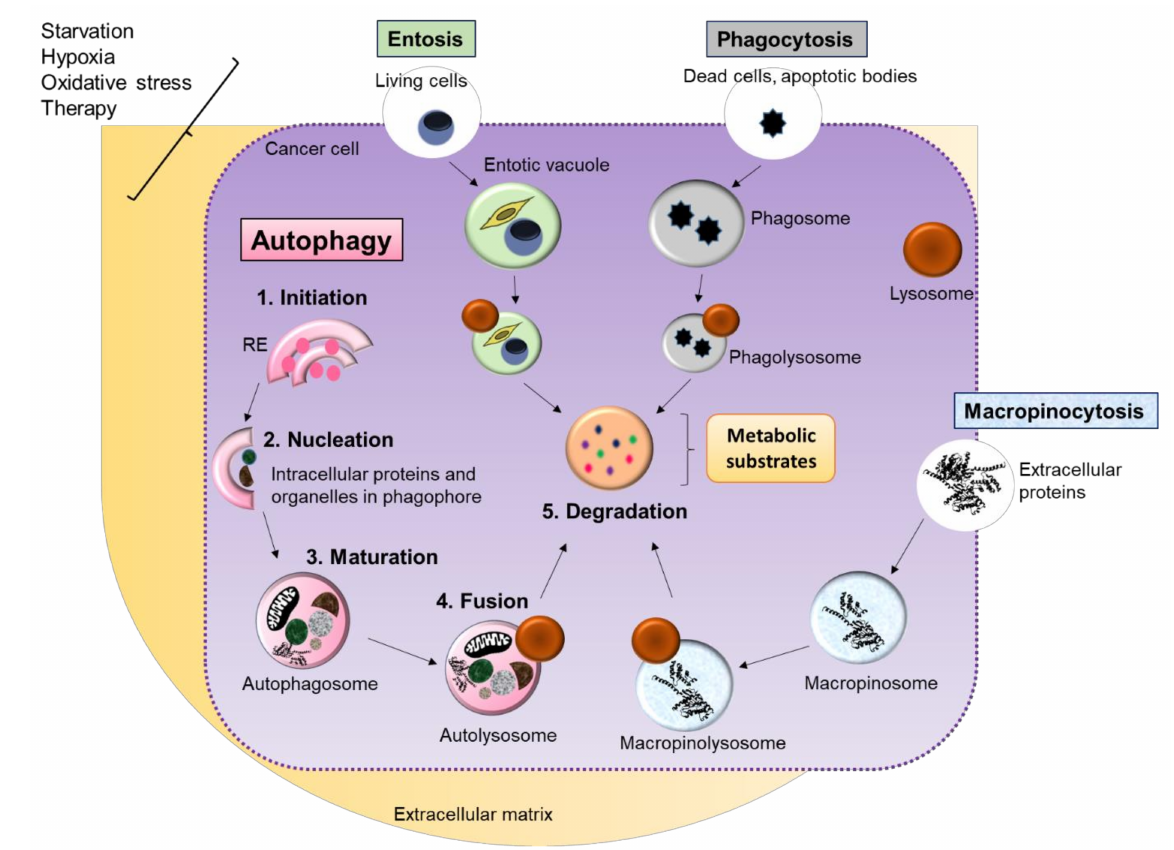
Figure 2. Autophagy and other scavenging ways of nutrient acquisition in cancer cells. Autophagy consists of the recycling of intracellular material (proteins and damaged organelles) to sustain cell survival. This process includes five steps: (1) initiation; (2) nucleation; (3) maturation; (4) fusion; (5) degradation. At first, different stressors such as starvation and hypoxia induce the breaking of the endoplasmic reticulum (ER) to form the phagophores. After, material is engulfed into double- membrane vesicles, the autophagosomes, which then fuse with lysosomes (autolysosomes) to deliver enzymes and acidification for macromolecule degradation. Other ways that enable tumor cells to scavenge nutrients from the TME and extracellular matrix include the uptake of proteins via macropinocytosis, entosis of living cells, and phagocytosis of dead cells and apoptotic bodies. These scavenging ways present similar key steps to the autophagy process, in which a mature structure containing material fuses with lysosomes to finally degrade macromolecules for generation of metabolic